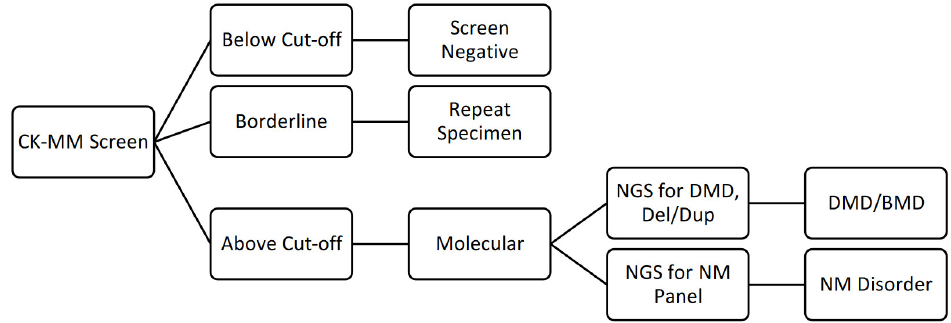
Figure 1. Screening algorithm used in the DMD pilot study. NGS: next-generation sequencing; Del/Dup: deletion/duplication; NM: neuromuscular.